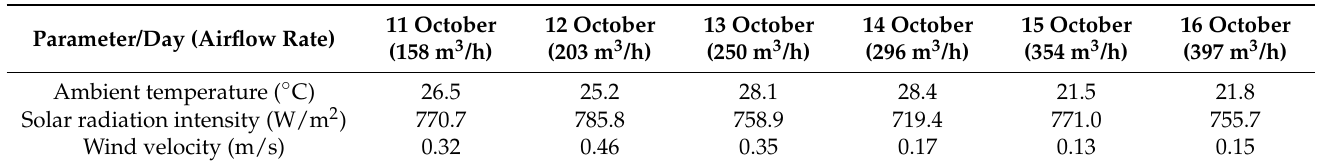
Table 2. GTC configuration: 30 mm-distance absorber—glazing. Mean values of meteorological parameters (time interval: 13:10–14:10).